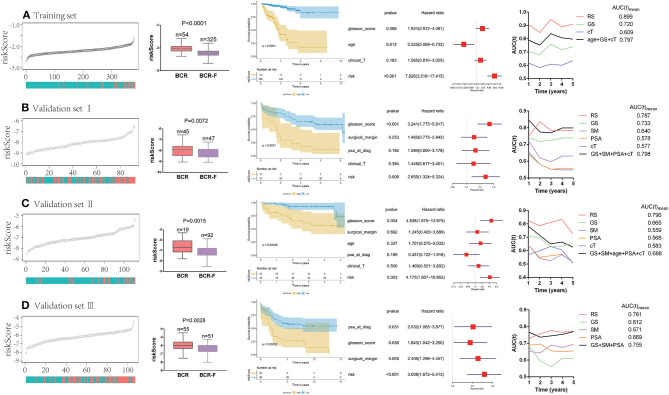
Predictive value of gene signature for biochemical recurrence (BCR) in each cohort (A–D). Risk scores of patients with BCR were obviously higher than the ones without BCR. Patients with a high risk had a significantly poorer recurrence-free survival (RFS) than those with a low risk. Multivariate Cox regression analysis demonstrated that risk score was an independent prognostic factor for BCR. Time-dependent receiver operating curve (ROC) analysis showed that risk score also acted as a powerful predictor of BCR.